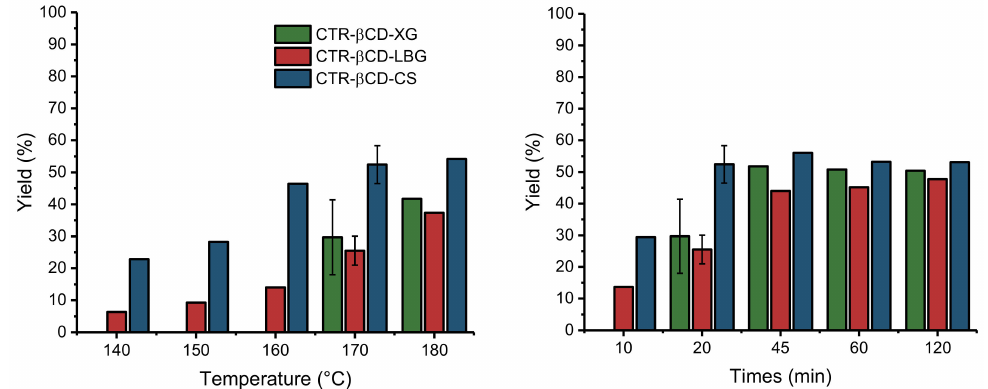
Figure 1. Yield of insoluble crosslinked fraction of xanthan gum (XG), locust bean gum (LBG) and chitosan (CS) with β -cyclodextrin and citric acid: processed for 20 min at di ff erent temperatures ( left ) and processed at 170 ◦ C for di ff erent times ( right ). (For the yield of the soluble crosslinked fractions, see Supplementary Materials, Figure S1). (Error bars obtained using n = 3 for those